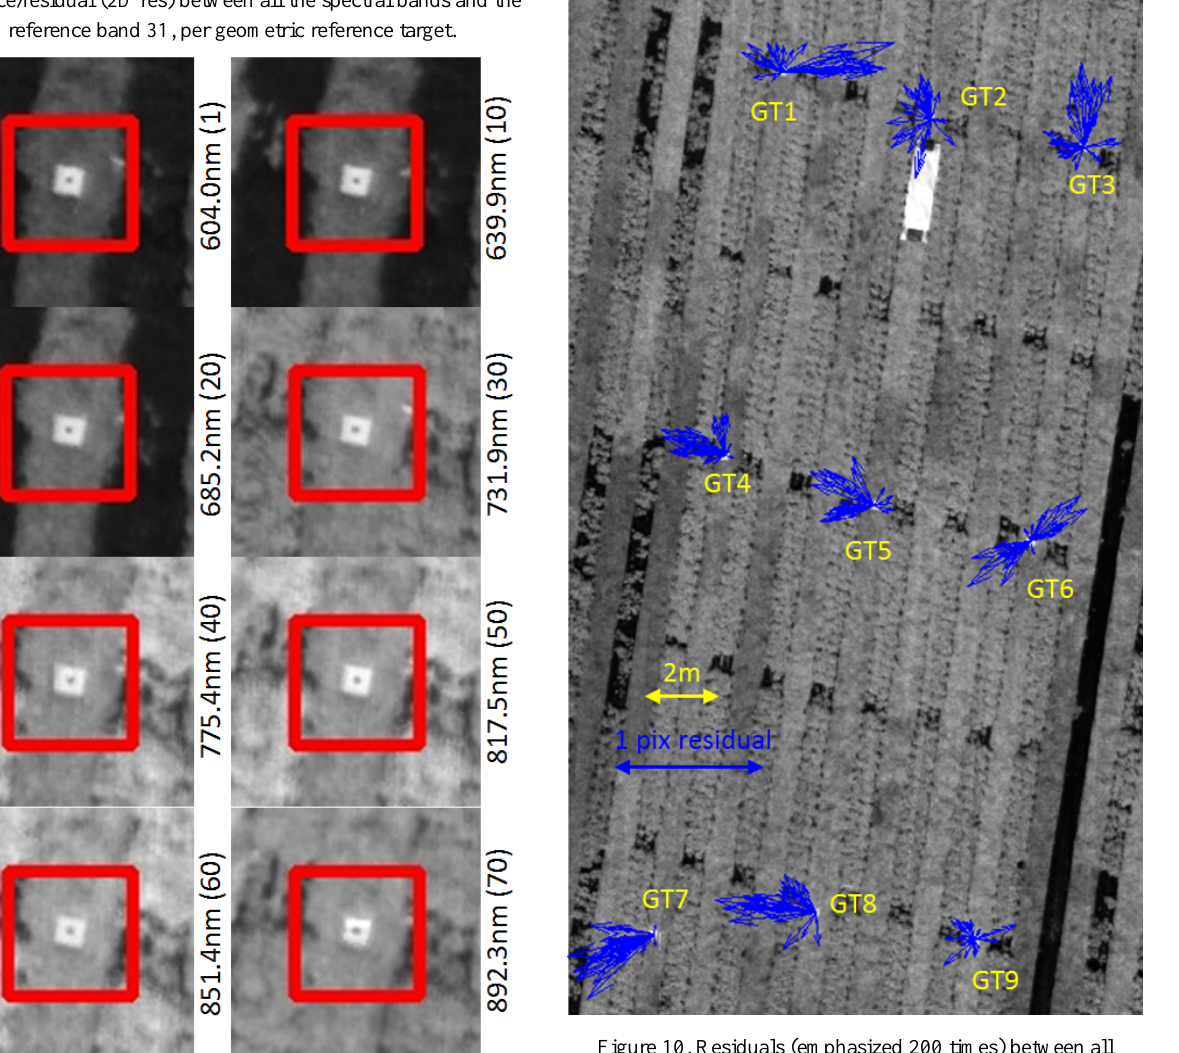
Figure 10. Residuals (emphasized 200 times) between all spectral bands and the reference band Figure 9. Neighbourhood (100pix x 100pix) of reference target GT1 in eight spectral bands (band number in brackets). Position of the matched template (50pix x 50pix extracted from band 31) marked in red.